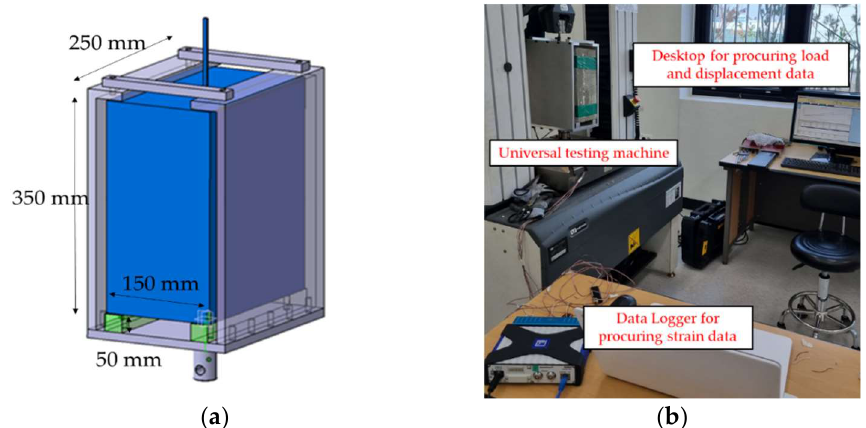
Figure 3. ( a ) Schematic of jig for holding the composites; ( b ) pull-out test setup.